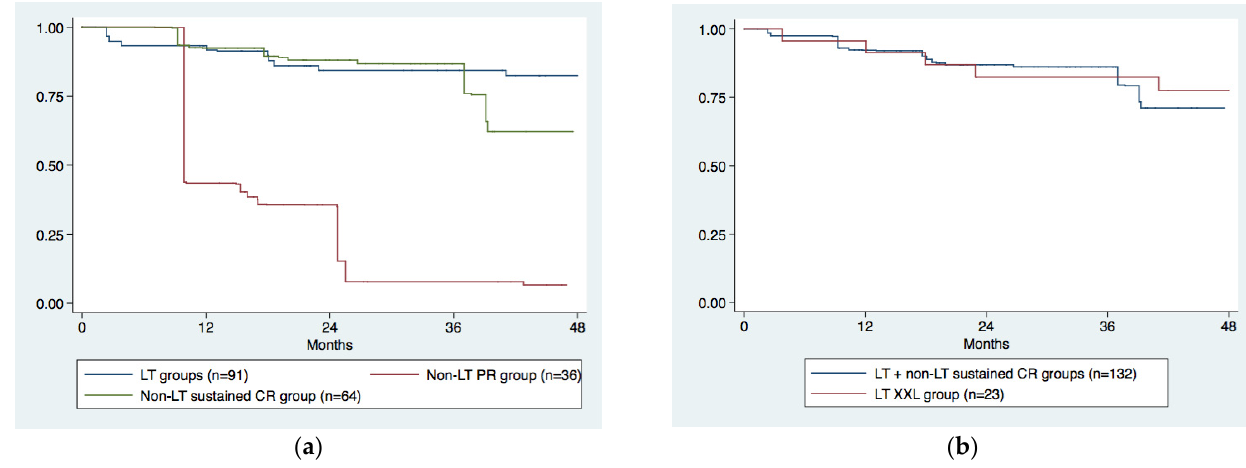
Figure 4. Kaplan–Meier survival curves comparing ( a ) non-LT study sustained CR group ( n = 64) vs. LT groups ( n = 91) and ( b ) LT study group + non-LT sustained CR group ( n = 132) vs. LT XXL group ( n = 23).